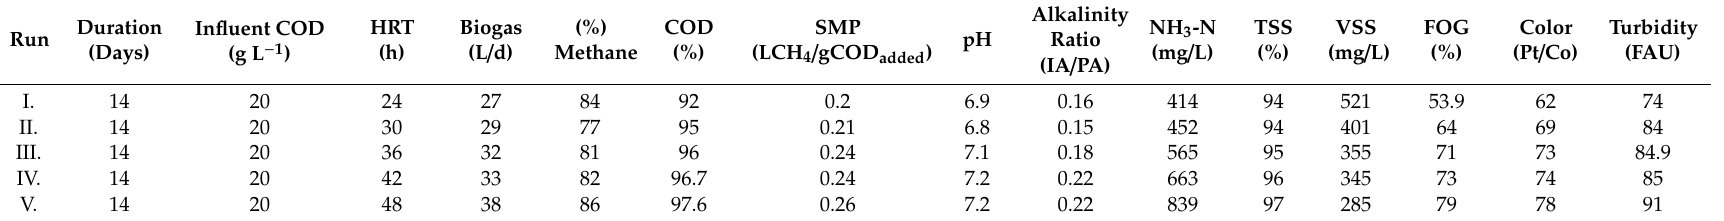
Table 4. Summary of the steady-state performance of the R2 UASB reactor treating CSWW relative increasing